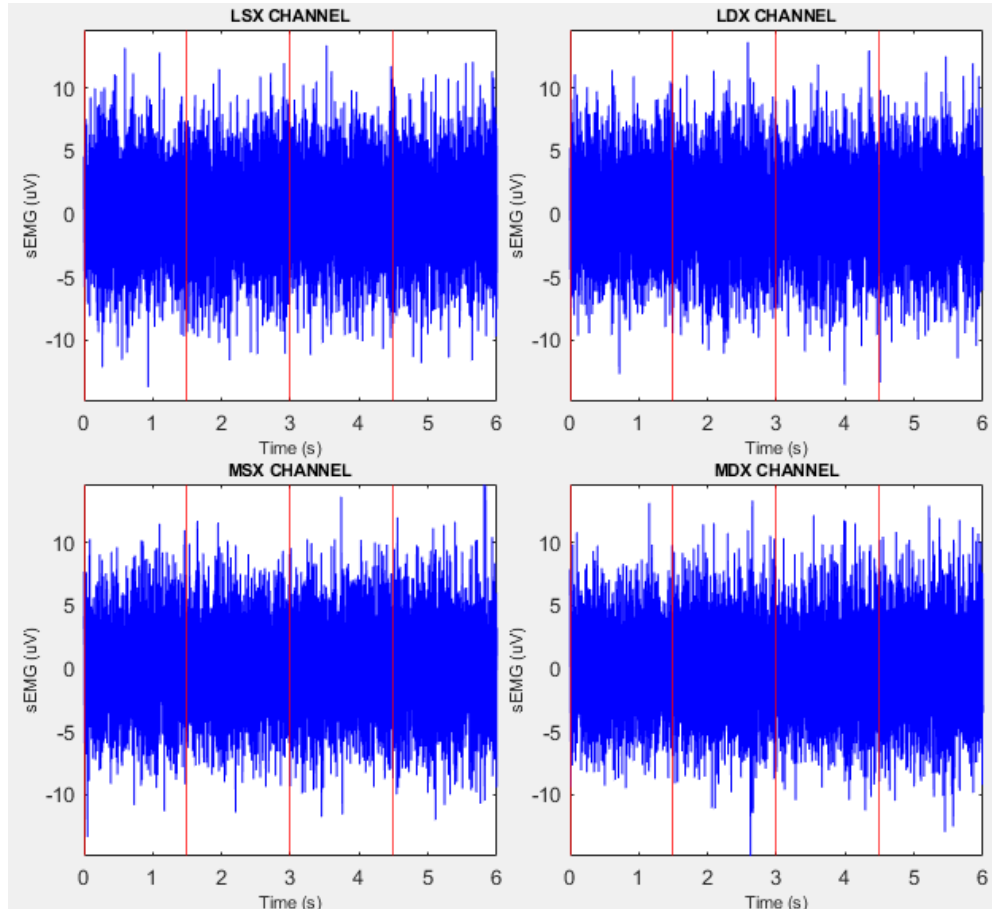
Figure 6. Real representation of Step 3 referred to the gold standard subject (ID2).